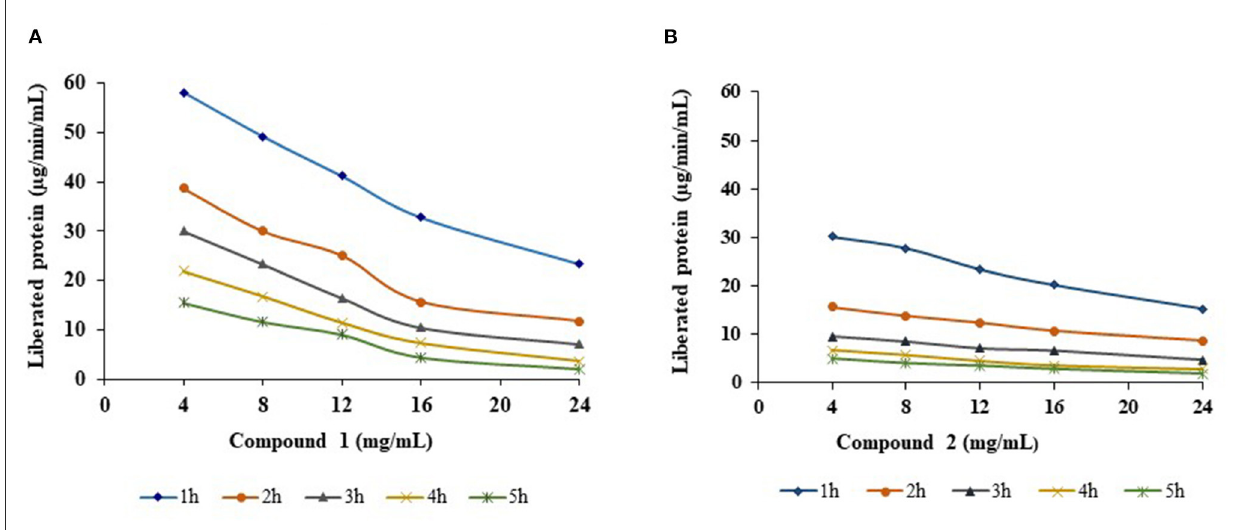
FIGURE4 Effect of compounds 1 (A) and 2 (B) on R-protease with different concentrations and different incubation